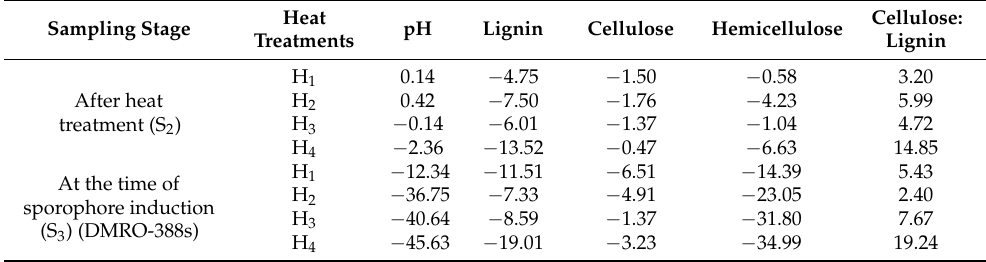
Table 2. Percentage of change in the lignocellulosic content of the wheat straw substrate due to heat treatment and solid-state